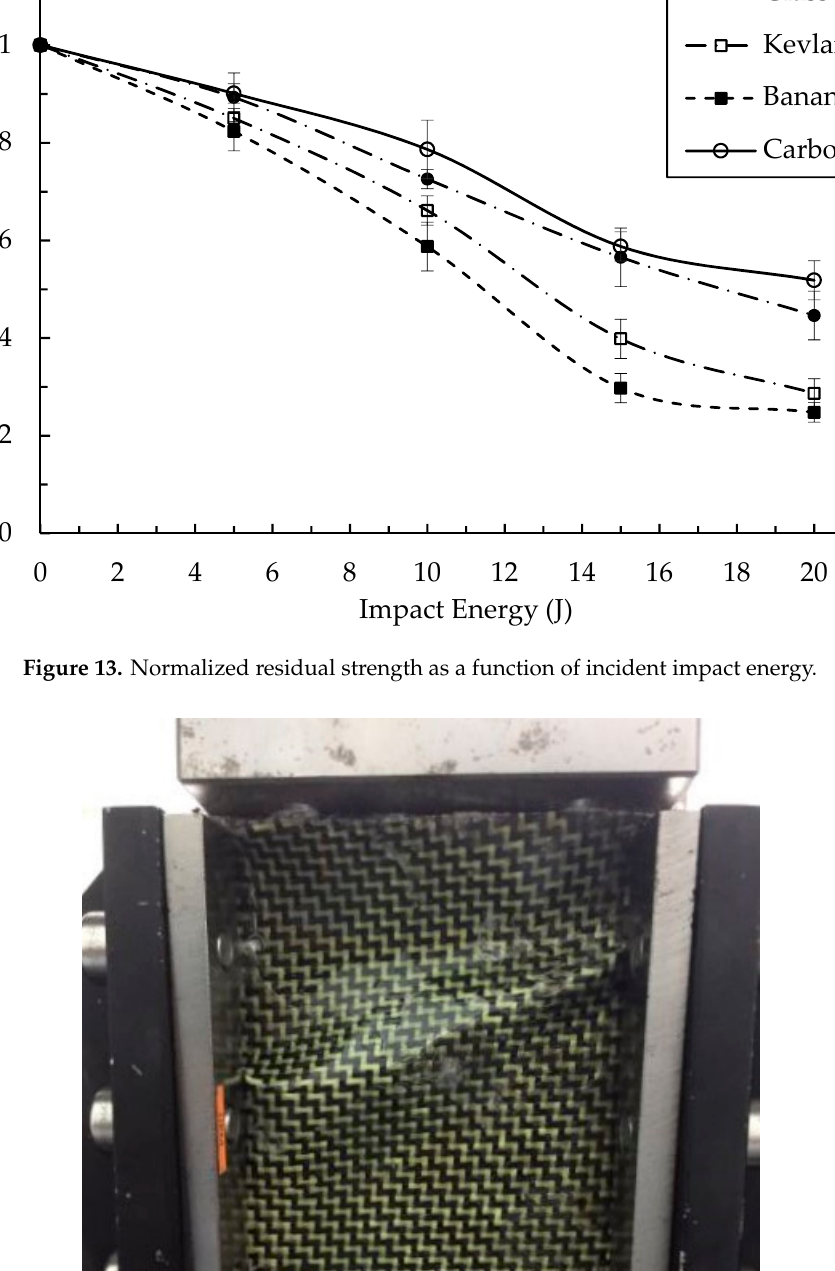
Figure 13. Normalized residual strength as a function of incident impact energy.